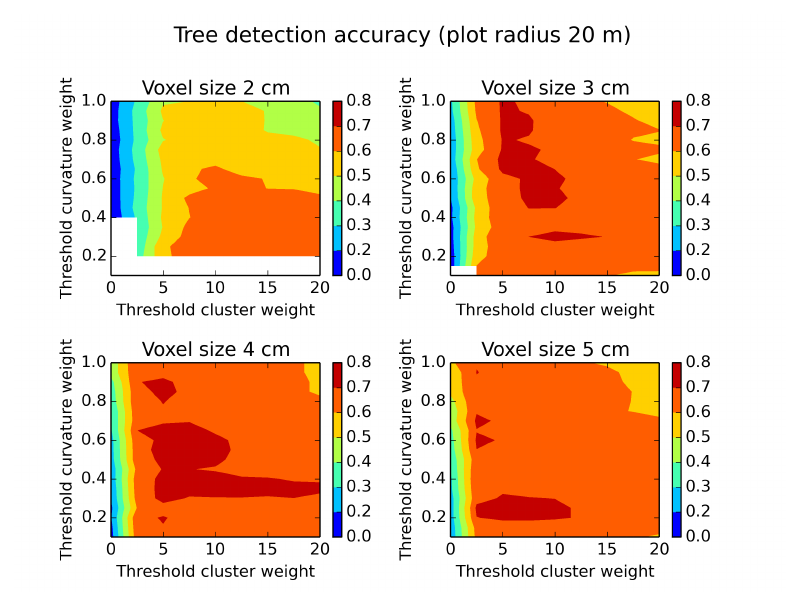
Figure 9. Tree detection accuracy evaluated on a plot of a radius of 20 m and different parameter settings. White areas indicate missing data. The optimum for high tree detection accuracy is achieved with different parameter settings for different voxel